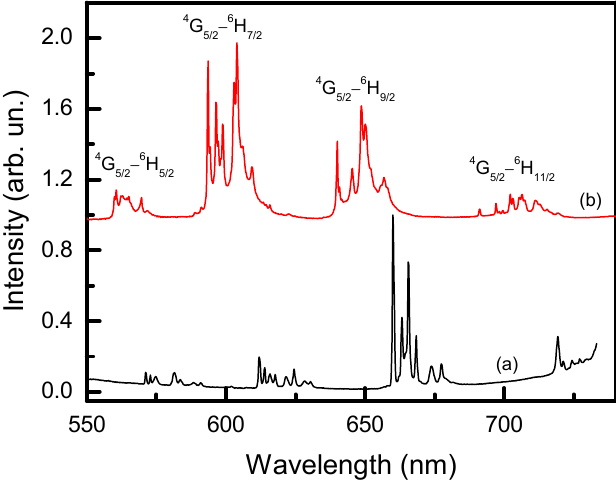
Figure 7. Photoluminescence spectra of ( a ) diamond crystals synthesized with 20 wt % of Sm 2 O 3 additives ( λ exc = 395 nm), and ( b ) Sm 2 O 3 powder ( λ exc = 473 nm). The spectra are normalized to the maximum intensity and displaced vertically for clarity.